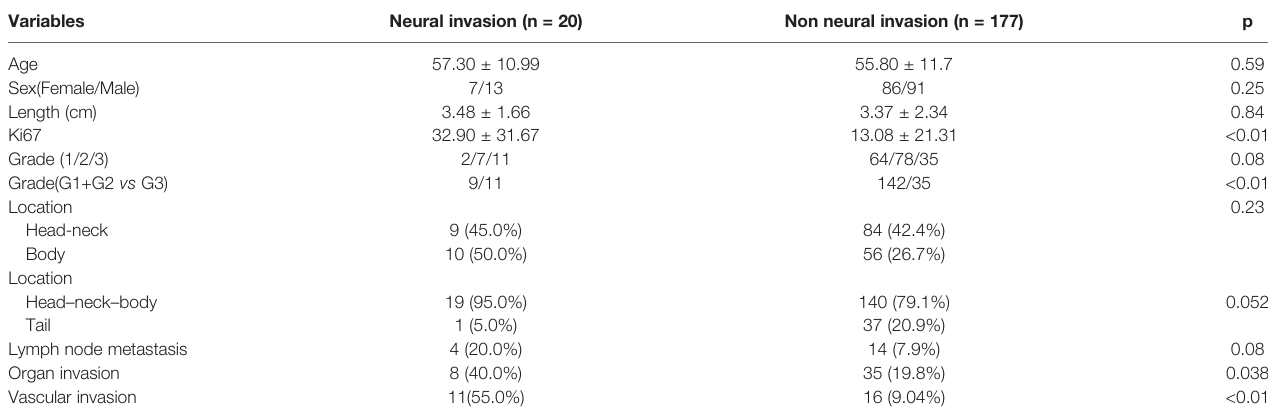
TABLE 1 | Characteristic of patients based on nerve